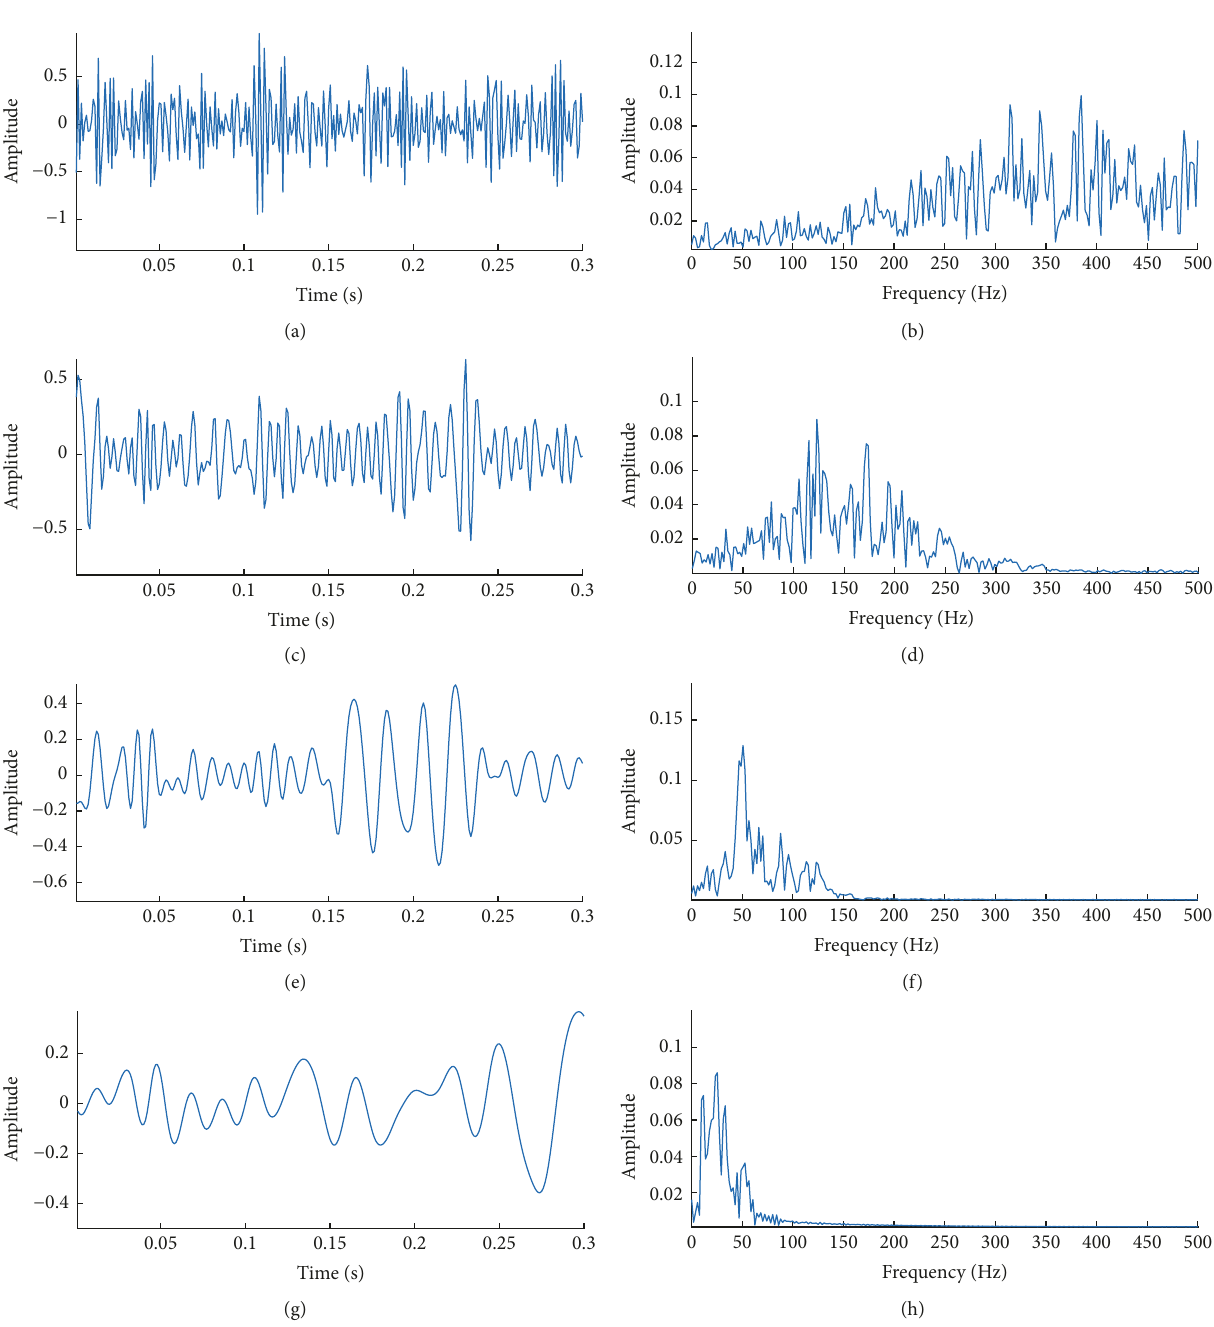
Figure 5: The IMF and spectrum with the vibration signal after the decomposition with ICEEMD: (a, c, e, and g) is IMF1 ∼ IMF4 and (b, d, f, and h) is IMF1 ∼ IMF4